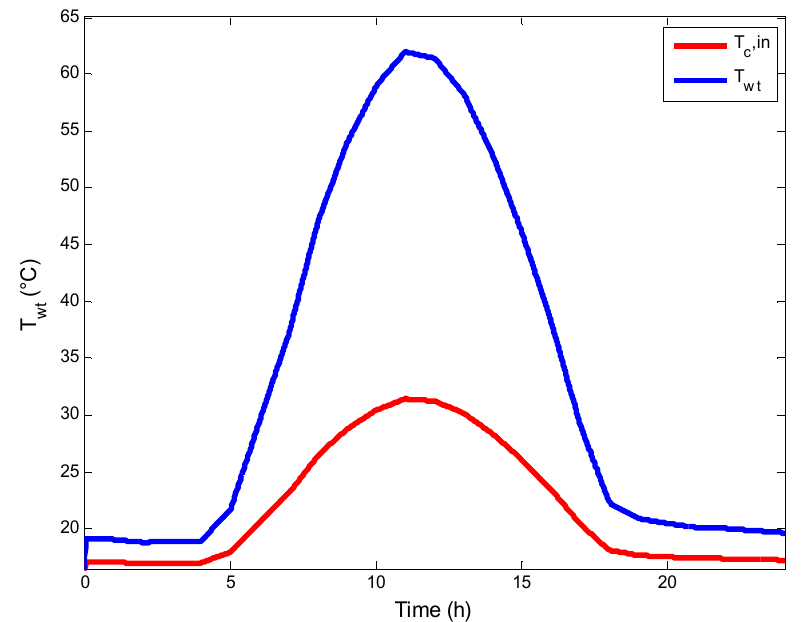
Figure 11. Variation of the inlet and outlet of saline water temperatures in the tank with time.